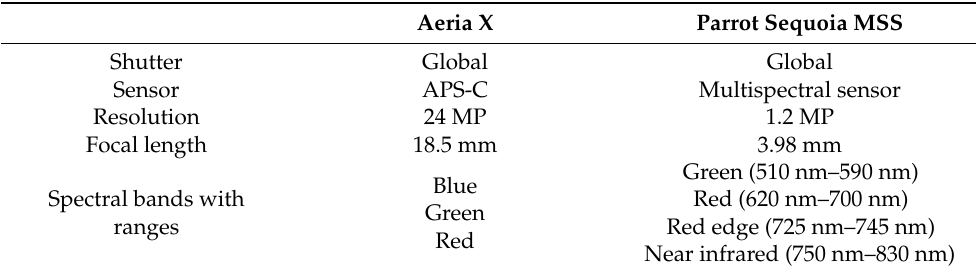
Table 1. Camera specifications for the Sensefly Aeria X and Parrot